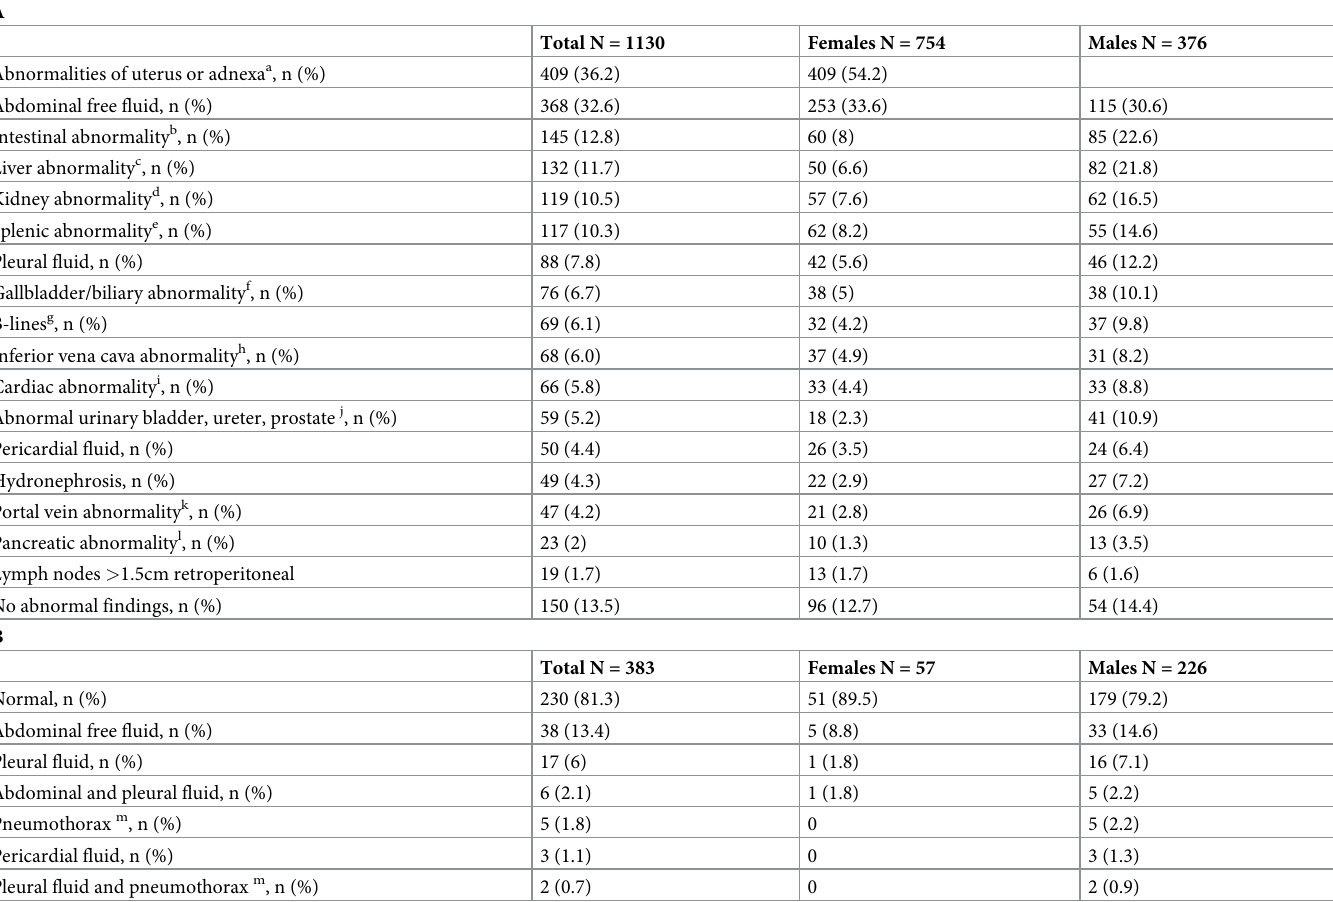
Table 3. A. Frequency of different findings in 1130 abdominal ultrasound examinations. B. Frequency of different findings in 283 eFAST